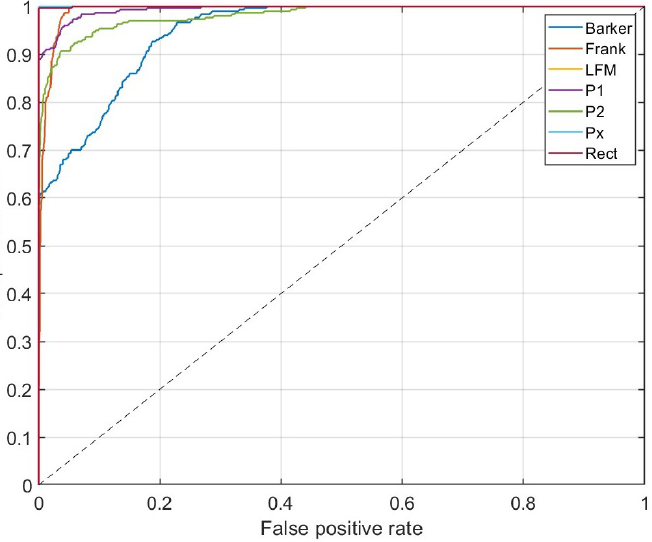
Figure 11. One-versus-all ROC curves for each class for the method with AWT with Morse wavelet parameters: γ = 9, β = 27.